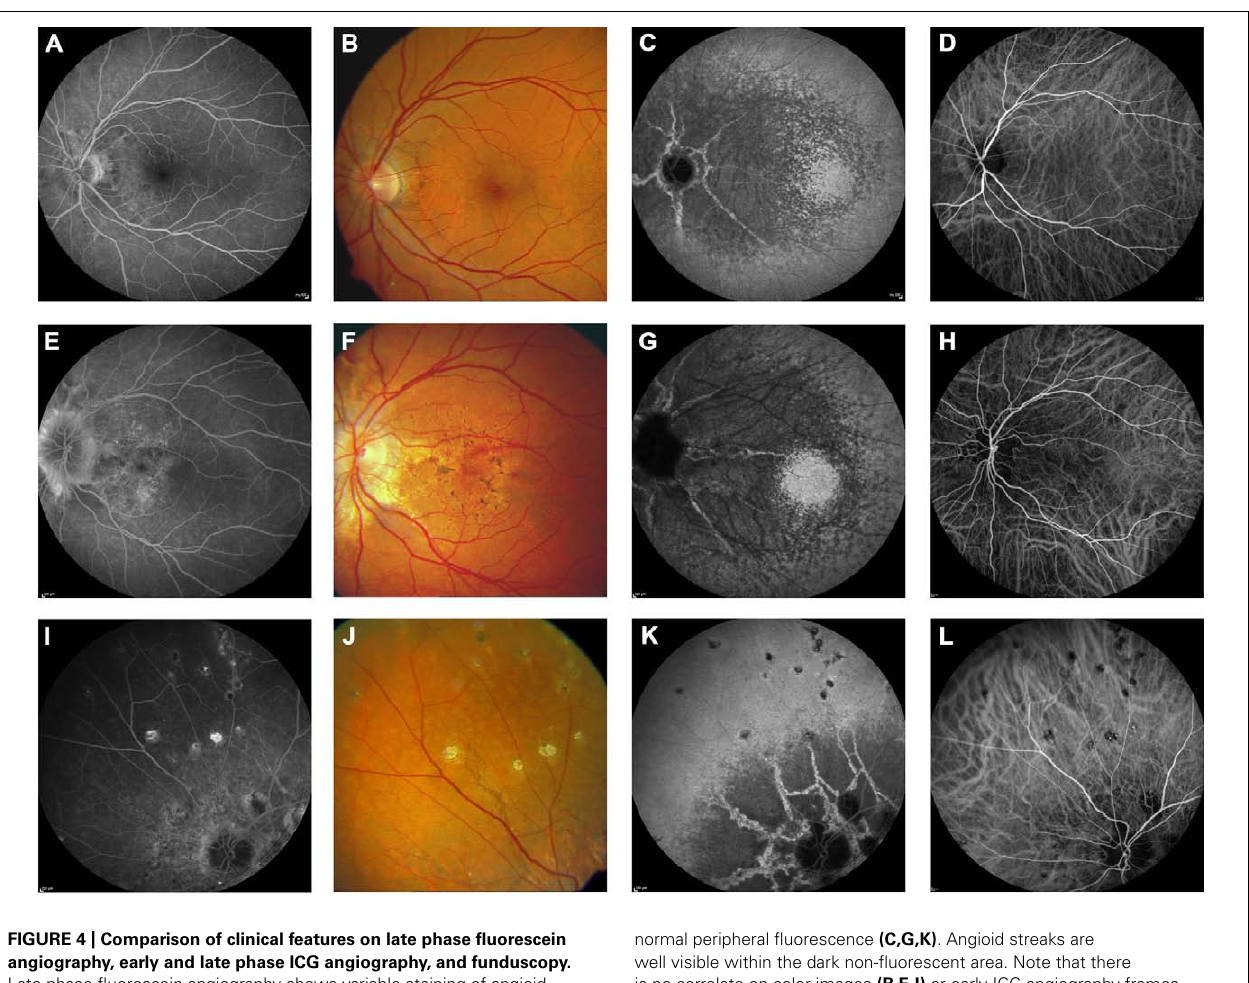
normal peripheral fluorescence (C,G,K) . Angioid streaks are well visible within the dark non-fluorescent area. Note that there is no correlate on color images (B,F,J) or early ICG angiography frames (D,H,L) . Comet tail lesions (J) usually are hyperfluorescent on late phase fluorescein angiograms (I) and hypofluorescent on ICG late phase angiogram (K)